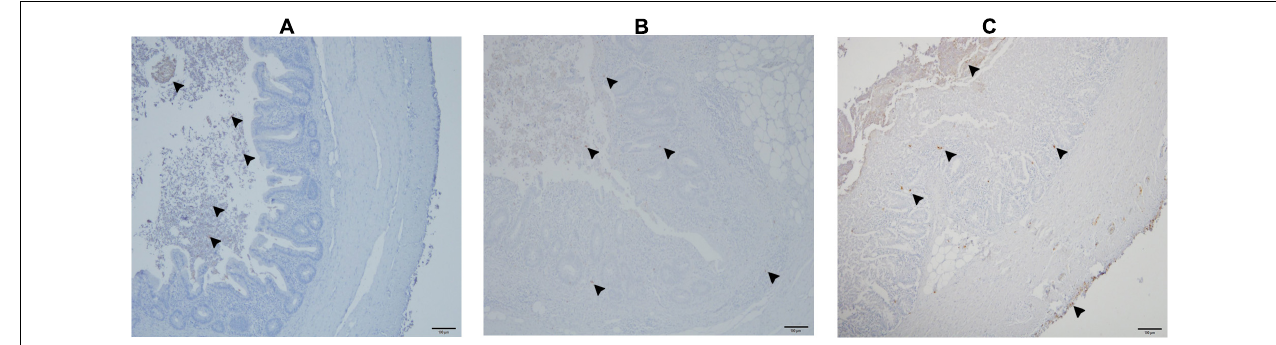
FIGURE 10 | Detection of E. coli in the cecum with immunohistochemistry. E. coli are only present in the lumen of cecum (arrow head) in a negative control bird from group 3 (A) ; presence of E. coli shown with arrowheads in the lumen, and mucosa of cecum in a co-infected bird in group 1 (B) ; profound presence of E. coli indicated with arrowheads entire cecal wall in the dead bird which also showed severe colibacillosis (C) .